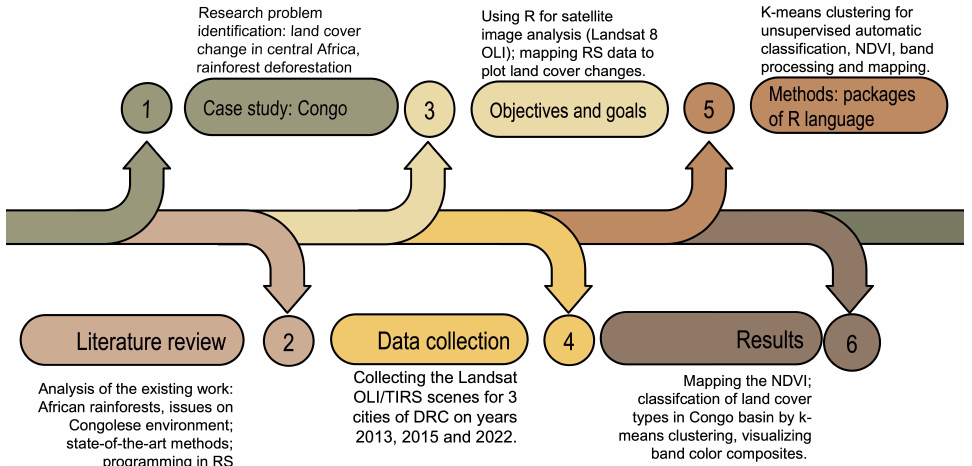
Figure 2. Workflow of the study project summarising general steps of the study, including aim and objectives, methodology and results used in a framework of R application for remote sensing data processing and land cover change detection by unsupervised classification (k-means clustering) of Landsat satellite images for selected regions of Congo,